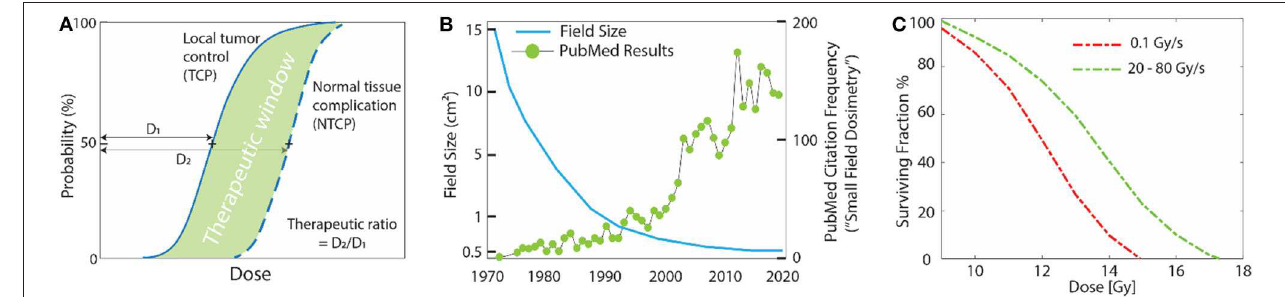
FIGURE 1 | (A) Typical dose-response curves in radiotherapy; maximum tumor control with minimal normal tissue complication is desired. (B) Over last the few decades this has been possible due to spatial modulation of the beam, leading to an increasing use of small fields ( < 10mm). Unfortunately, this led to complex dosimetric issues unique to small fields that standard dosimeters were not suitable for. The x-axis in the in (B) denotes the time-line of major advancements that have happened in the field of external beam radiotherapy. Left scale denotes how typical field sizes have varied with these advancements and right scale shows the number of peer-reviewed publications per year based on a PubMed search of the phrase “Small Field Dosimetry.” (C) The effect of ultra-high dose rates on cell survival curves. Data adapted from Hornsey et al. [2], where decreased cell killing was seen in mouse intestine at high dose-rates vs. low dose-rates. The decrease in cell-killing was attributed to rapid depletion of oxygen, which is required to “fix” DNA damage, at high dose-rates.